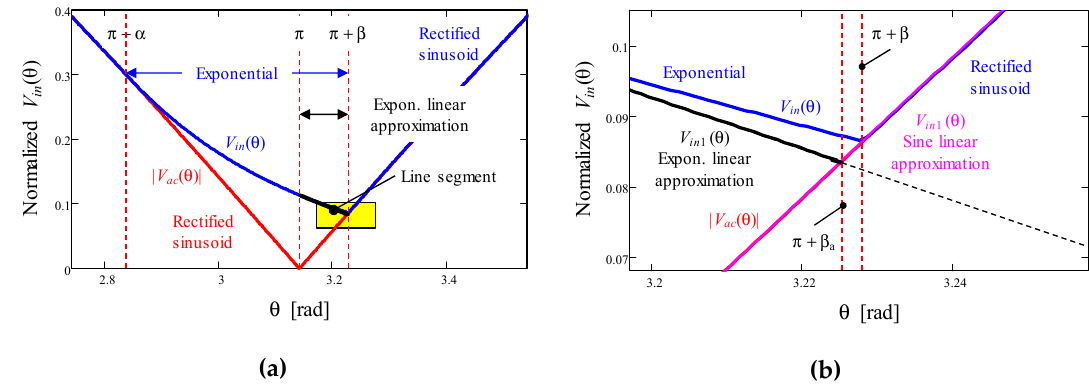
Figure 13. Detail of V ac ( θ ) (red trace) and V in ( θ ) (blue trace) near voltage zero-crossing ( a ), and zoomed view of the yellow area, intersection of V ac ( θ ) and V in ( θ ) ( b ). Values are normalized to V PK .